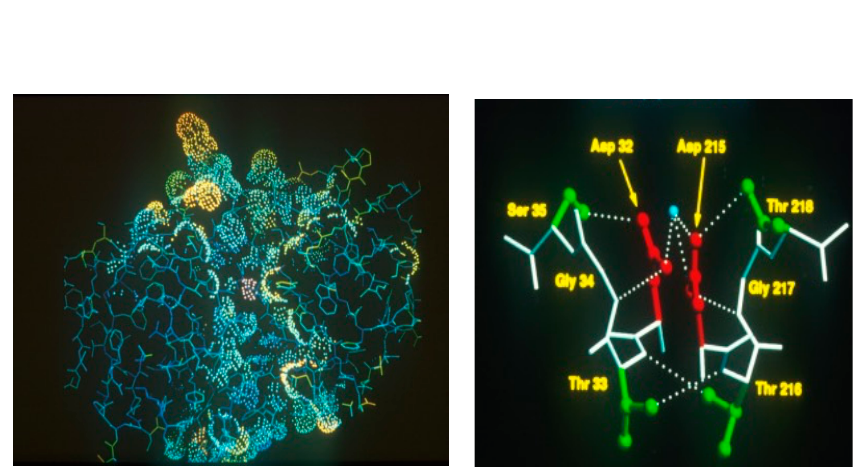
Figure 3. ( A ) The aspartic protease fold found in pepsin and other aspartic proteases, showing a deep active site cleft. ( B ) The symmetrical arrangement of the two catalytic aspartates in the active site of pepsins located in the duplicated sequence Asp-Thr-Gly related by the pseudo 2-fold axis in the structure.